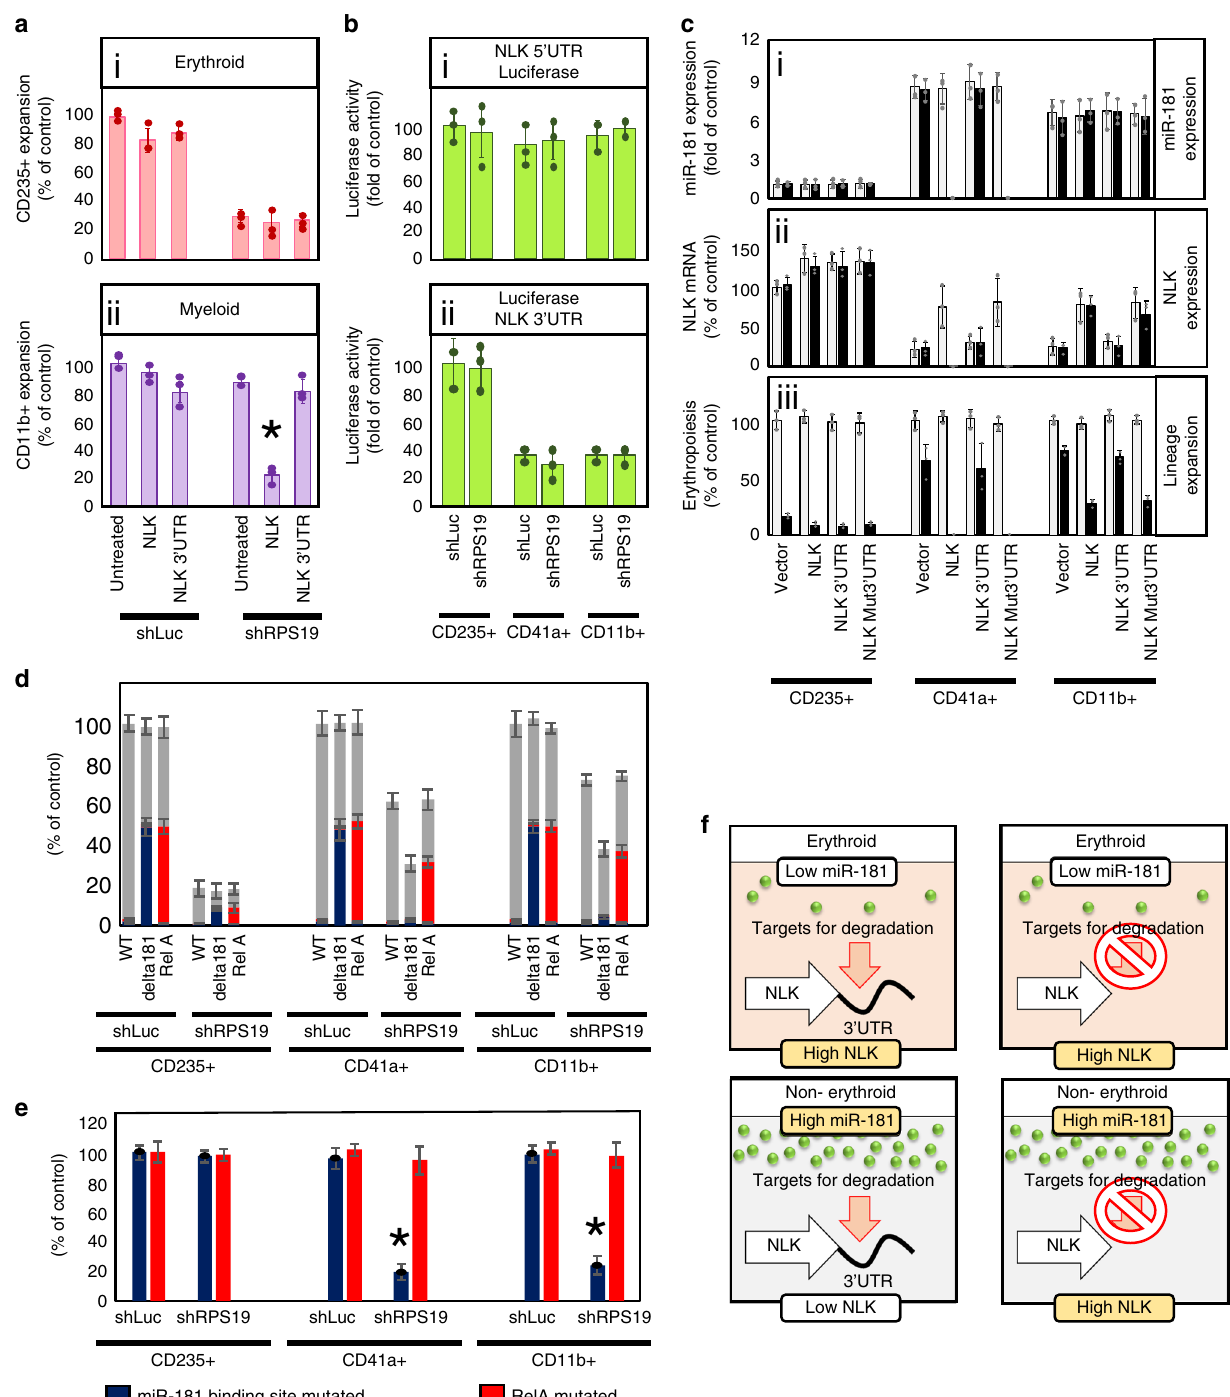
RelA mutated human hematopoietic cells. After screening guide RNAs (gRNAs) (Fig. 5e red bars) was determined. In ribosome-competent cells in that selectively target the potential miR-181 binding site (see excess of 40% of cells were successfully mutated by both NLK 3 ′ Supplementary Fig. 6e), gRNA, along with Cas9, were electroporated UTR- and RelA-targeting in all three cell lineages. Even with 40% into control and RPS19-insuf fi cient CD34 + HSPCs. As a control, cells carrying mutations, no reduction in cell population was gRNA targeting RelA was introduced. Cells were differentiated prior observed (Fig. 5d). to counting, sorting and sequencing to determine the percentage of A different pattern was observed in RPS19-insuf fi cient progenitor cells baring mutations in NLK 3 ′ UTR (a schematic of the cells. The percentage of cells with NLK 3 ′ UTR or RelA mutations experiment is presented in Supplementary Fig. 6f). was not signi fi cantly different from controls (Fig. 5d blue and red Subsequently, CD235 + , CD41a + , and CD11b + numbers were bars) and the mutations do not impact the total cell population calculated (Fig. 5d gray bars). After sequencing, the percentage of (Fig. 5d gray bars). In RPS19-insuf fi cient CD41a + megakaryocyte and CD11b + myeloid populations (Fig. 5d gray bars) a signi fi cant cells baring mutations in NLK 3 ′ UTR (Fig. 5e blue bars) and RelA